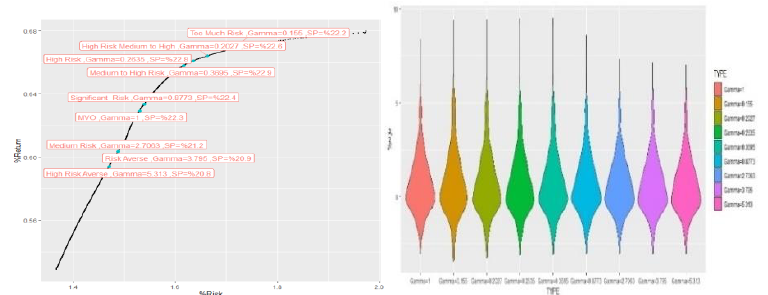
Figure7 . Efficient boundary and Violet diagram for training data and position of